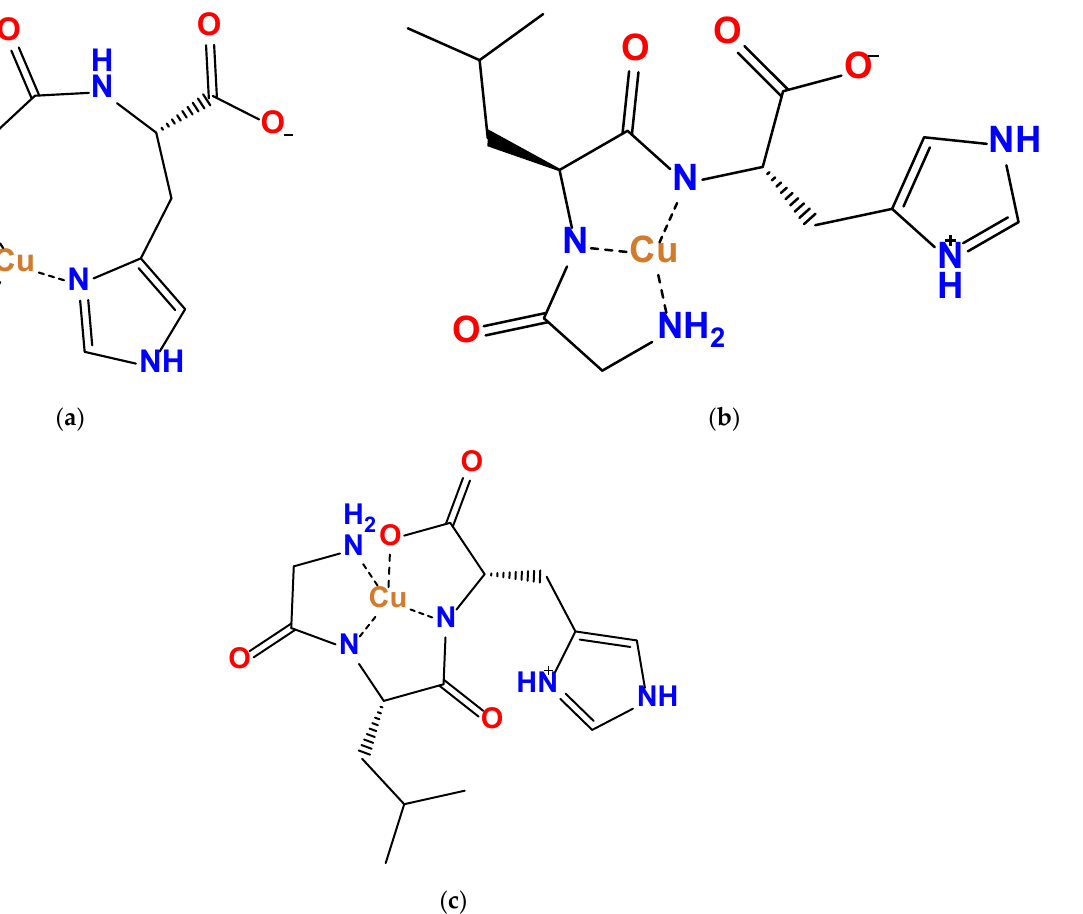
Figure 4. The three coordination modes ( a ) with an amine-N, neighboring amide-N and imidazole-N coordination, ( b ) with an amine-N and two amide-Ns coordination and ( c ) with an amine-N, two amide-Ns and carboxyl-O coordination for the MLH -1 species of GLH.